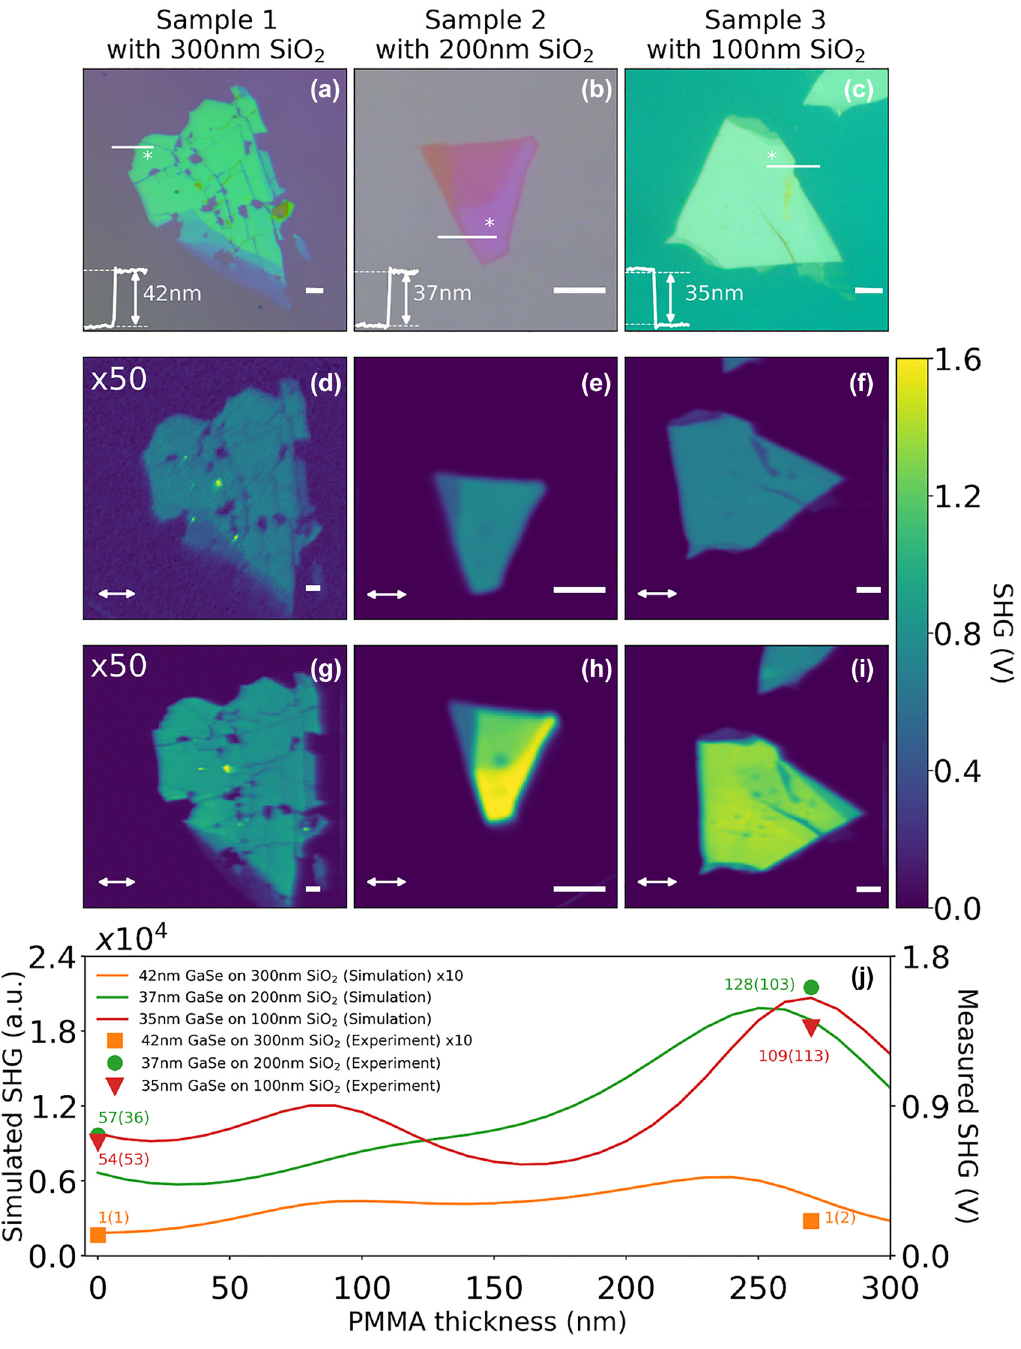
Figure 3: Summary of the experimental studies on the single GaSe FP structure Optical image of: (a) S1 (reference sample): 42 nm GaSe/300 nm SiO (b) S2: 37 nm GaSe/200 nm SiO and (c) S3: 35 nm GaSe/100 nm SiO . Thickness of each flake in the region of interest indicated by the AFM line profile 2 2 shown as an inset. (d–f) SHG images without PMMA coating for samples S1 to S3. (g–i) SHG image with PMMA coating for samples S1 to S3. (j) Comparison between experimental SHG data points for samples S1 to S3, and simulation results showing SHG signal as a function of PMMA layer thickness. Scale bar for all optical and SHG image correspond to 5 μ m. The input polarization of the fundamental is indicated by the double-sided arrow in the SHG image. SHG enhancement factors for experiments (simulation) are indicated next to the experimental data